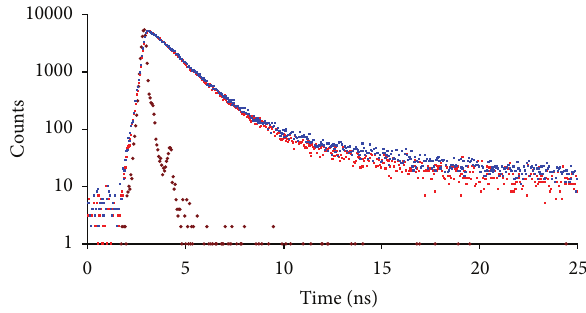
Figure 6: Stern-Volmer plot 𝐼 0 /𝐼 versus [SnO 2 ] of FN, EN, and ERN dyes.